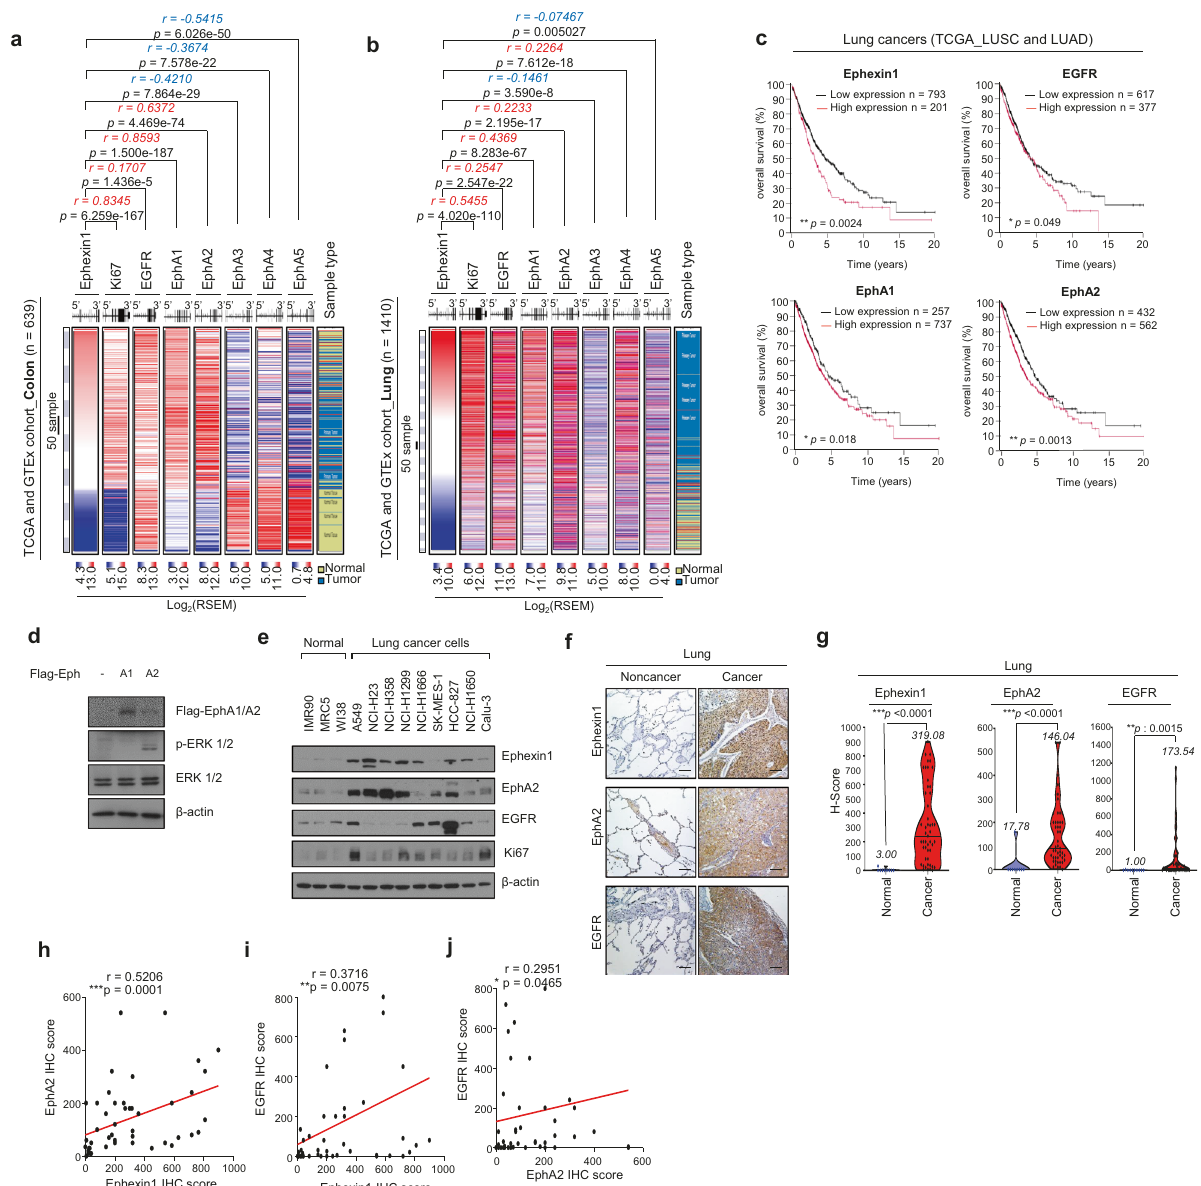
Fig. 1 Aberrantly high levels of the cell receptors EGFR, EphA2, and Ephexin1 are associated with lung and colorectal cancers. a, b Associations between Ephexin1, Ki67, EGFR, and EphA1-5 levels and tumor tissues were identi fi ed by analyzing the TCGA (COAD, COADREAD, LUAD, LUSC) and GTEx datasets. Positive correlations are expressed as mean Spearman r, and p values are for a two-tailed Student ’ s t test. c Kaplan-Meier analysis of overall patient survival as related to expression levels of Ephexin1, EGFR, EphA1 and EphA2 in lung cancer patients (TCGA_LUSC and TCGA_LUAD). The p values are for a log-rank test. d Western blot analysis using the indicated antibodies after transfection of HEK293T cells with either control vector or plasmid expressing Flag-tagged EphA (A1 and A2). e Western blot analysis of EGFR, EphA2, Ephexin1 and Ki67 expression from normal and cancer lung cell lines. f Immunohistochemical staining for EGFR, EphA2 and Ephexin1 in cancerous ( n = 40) and corresponding normal tissue ( n = 10). Scale bar = 100 μ m G Immunohistochemistry (IHC) score for the data shown in ( f ). Student ’ s t-test and data are shown as mean ± SEM, ** P < 0.01, and *** P < 0.001. h – j A correlation of IHC levels between Ephexin1 and EphA2 ( h ), Ephexin1 and EGFR ( I ), and EphA2 and EGFR ( j ). Correlated analyses are shown as mean Spearman r, and p values are for a two- tailed Student ’ s t test. * P < 0.05, ** P < 0.01, and *** P < RESULTS expression of discovery set was transformed into log2 scale and correlation analysis was visualized using the UCSC Xena browser software. The overexpression of Ephexin1, EGFR and EphA2 receptors is correlated to lung and colorectal cancers Recently, we reported that Ephexin1 is abnormally overexpressed Statistics in lung and colorectal cancers and that lack of Ephexin1 effectively Data were presented as mean ± SEM of three independent experiments suppresses lung and colorectal cancers [36]. Based on previous and signi fi cant differences between groups were assessed by two-tailed paired Student ’ s t -test or Two-way ANOVA using GraphPad Prism reports, we hypothesized that there may be an association (GraphPad Software Inc., CA, USA). Results with a value of * P < 0.05, ** P between EGFR/Ras signaling and EphA/Ephexin1 signaling. To < 0.01, and *** P < 0.001 were considered statistically signi fi cant.